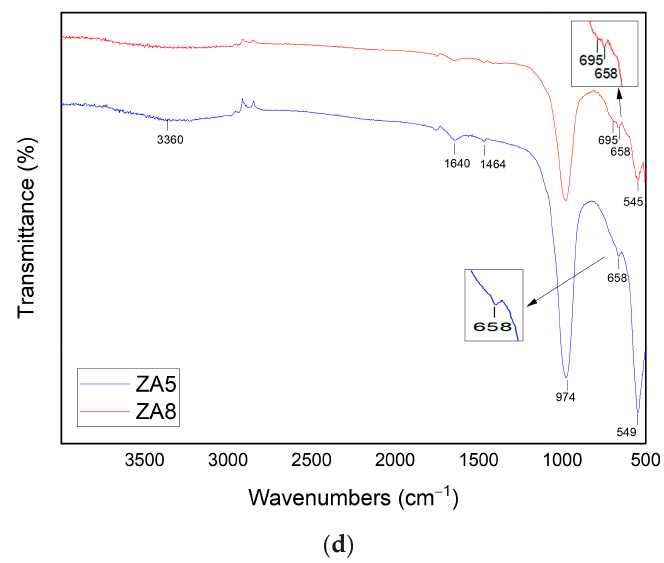
Figure 5. XRD pa tt erns of synthesized zeolites ZA5 and ZA8 ( a ), * sodalite and ° LTA). SEM micro- Figure 5. XRD patterns of synthesized zeolites ZA5 and ZA8 ( a ), * sodalite and ◦ LTA. SEM micro- graphs of ( b ) ZA5 and ( c ) ZA8. FTIR spectra for ZA5 and ZA8 ( d ). graphs of ( b ) ZA5 and ( c ) ZA8. FTIR spectra for ZA5 and ZA8 ( d